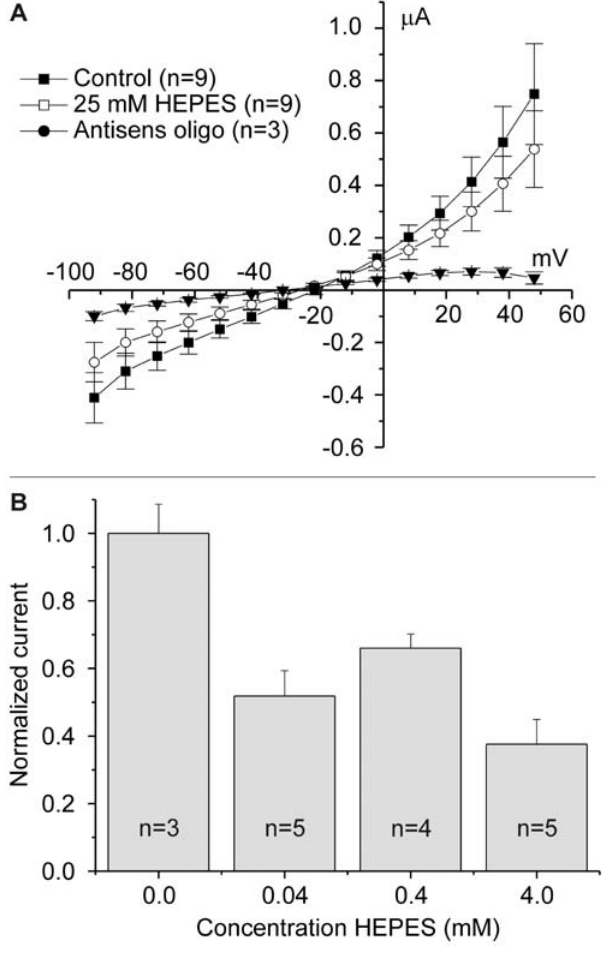
Figure 4. HEPES inhibits Cx55.5 hemichannel-mediated cur- rents in Xenopus oocytes. A , Mean currents of 9 oocytes are plotted as function of potential. The control current (filled squares) is inhibited by application 25 mM HEPES (open circles). No current is present in antisense injected oocytes (filled triangles). Error bars= 6 sem. B . The mean reduction in Cx55.5 hemichannel current at potentials between 2 55 and 2 35 mV. At a concentration of 4 mM HEPES, the hemichannel mediated current decreased to 37.9 6 0.07% (n=7; p , 0.001). All tested concentrations of HEPES induced a significant reduction of the Cx55.5 hemichannel current (40 m M HEPES: p=0.0065, n=5; 0.4 mM HEPES: p=0.0118, n=4; 4.0 mM HEPES: p=0.00165, n=5).